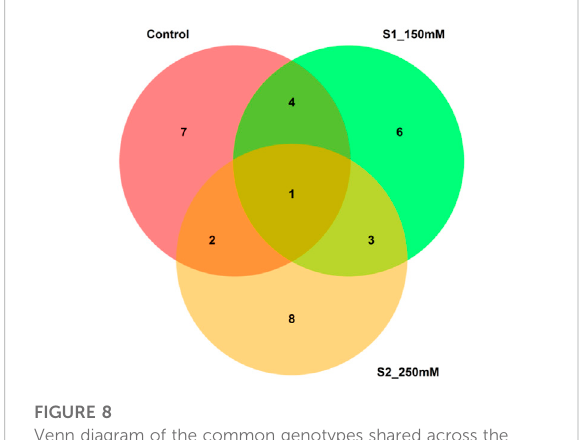
FIGURE 8 Venn diagram of the common genotypes shared across the